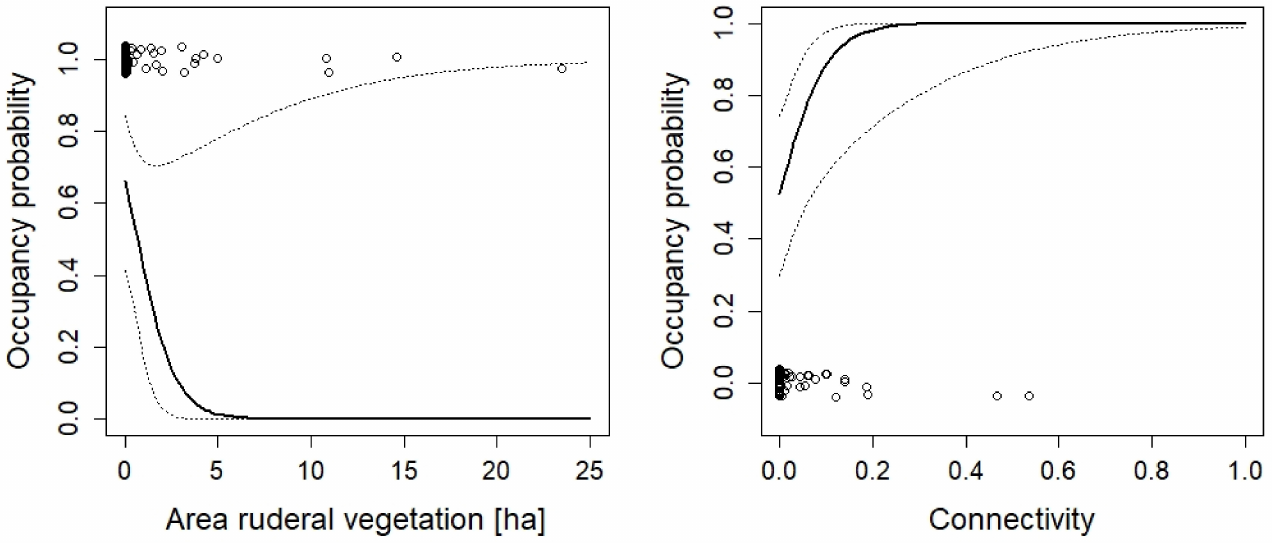
Figure 12. The effect of connectivity and the area of ruderal vegetation on the occupancy probability of Triturus cristatus . For additional explanations, see the caption of Figure